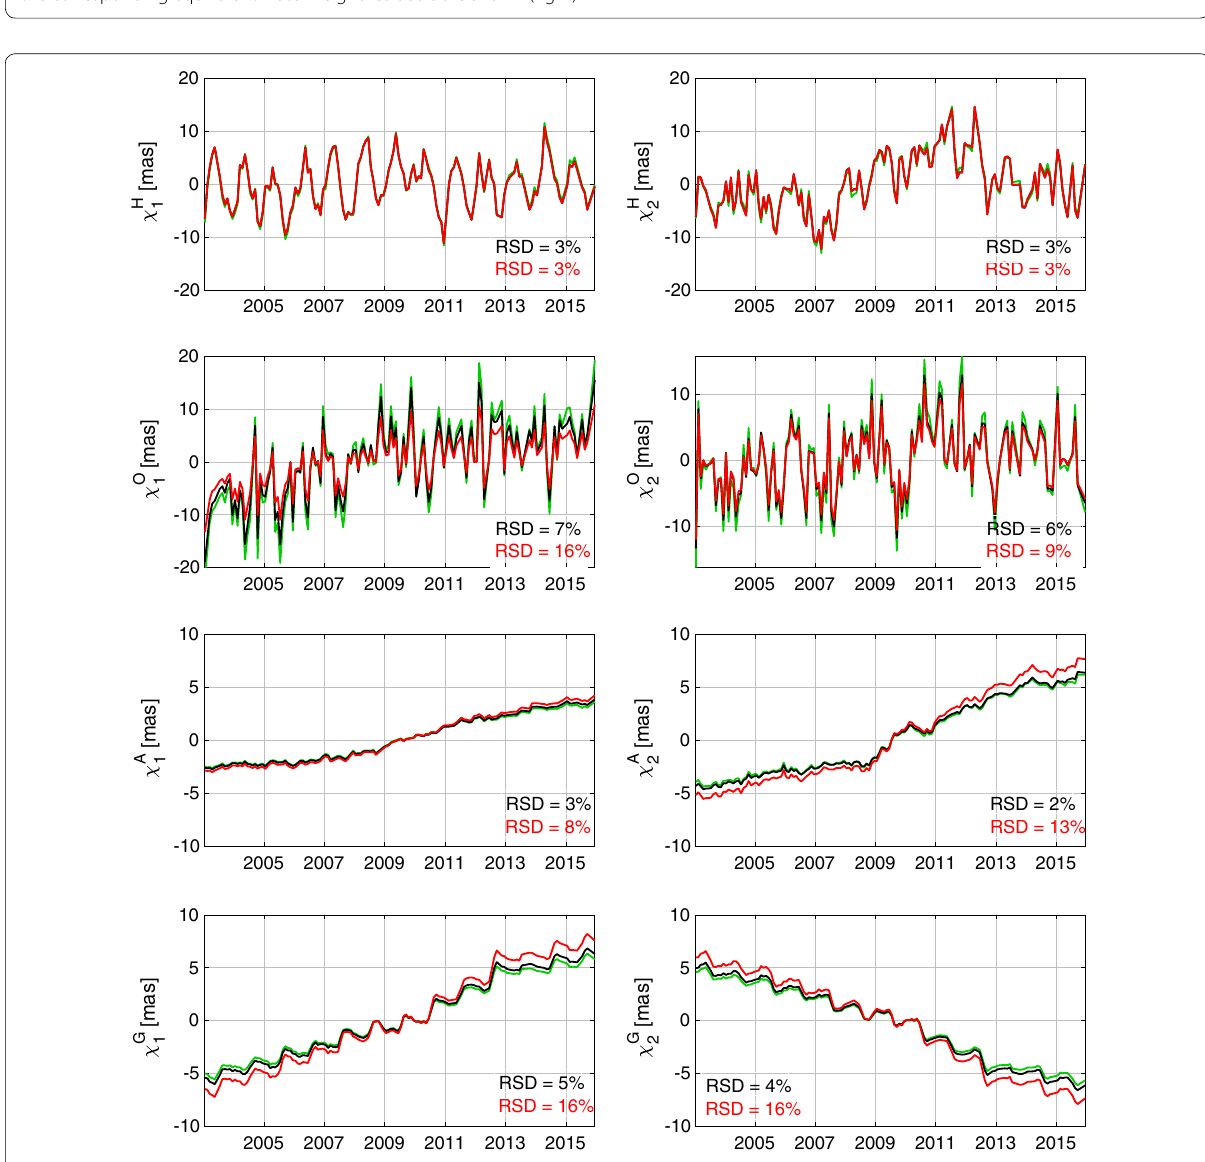
Fig. 8 Polar motion excitation functions for the continental hydrosphere χ H , oceans χ O , Antarctica χ A and Greenland χ G derived from GRACE GFZ RL06 gravity field solutions by applying (1) only the DDK filter (green), (2) the DDK filter and the gain factors k (black) and (3) the DDK filter, the gain factors k and the scaling factors f i